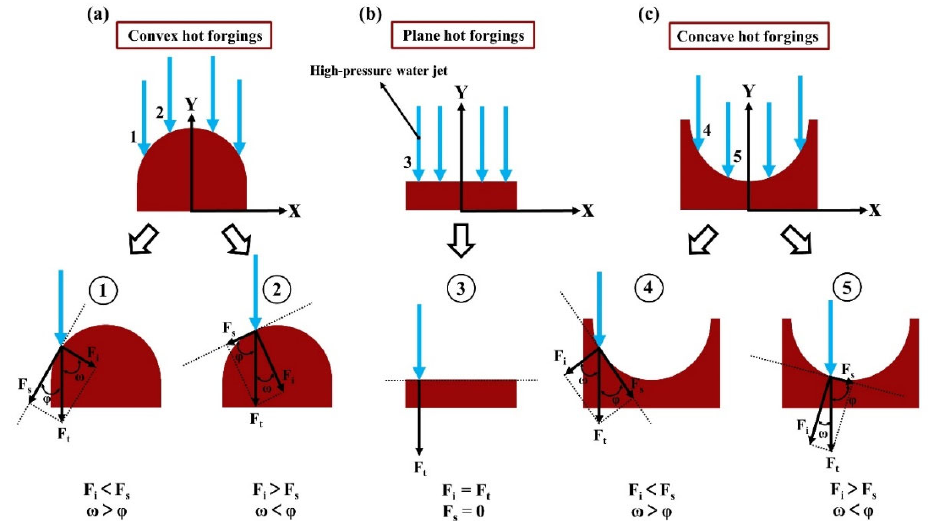
Figure 12. A schematic diagram of force analysis for high ‐ pressure water jets impinging on the typical hot forging surfaces: ( a ) Convex hot forgings; ( b ) Plane hot forgings; ( c ) Concave hot forgings. To start with, when the high ‐ pressure water jets impinge on the typical hot forging surfaces, there exists the total force F t , which can be divided into the impact force F i and shear force F s . The F i and F s increase with increasing F t . Moreover, the angle between F i and F t is defined as ω , while the angle between F s and F t is defined as φ . The relationship between the values of ω and φ is contrary to that between F i and F s . As can be seen from Figure 12a, the total force F t disperses into F i and F s when blue arrow 1 or 2 impinges on a convex surface of a typical hot forging. Blue arrow 1 corresponds to F i < F s and ω > φ . Meanwhile, blue arrow 2 corresponds to F i > F s and ω < φ . The presence of F i = F t and F s = 0 in Figure 12b when blue arrow 3 is impinging on the plane hot forging is due to the lack of dispersion of the high ‐ pressure water jet. When blue arrows 4 and 5 impinge on the concave surface of hot forging in Figure 12c, blue arrow 4 corresponds to F i < F s and ω > φ . Meanwhile, blue arrow 5 corresponds to F i > F s and ω < φ . On the typical hot forging. The larger the value of F i , the easier it is to remove the oxide scale from the typical hot forging surface, and vice versa. On the other hand, F i and F s are primarily attributed to ω and φ when the high ‐ pressure water jet impinges on the hot forging surface. The values of ω and φ depend on the position where the high ‐ pressure water jet impinges on the surface of the hot forging. More specifically, it is evident that the value of φ is proportional to the value of F i , while the value of ω is inversely propor ‐ tional to the value of F i . In other words, the value of F i is related to the position where the high ‐ pressure water jet impinges on the typical hot forging surface. The angle between